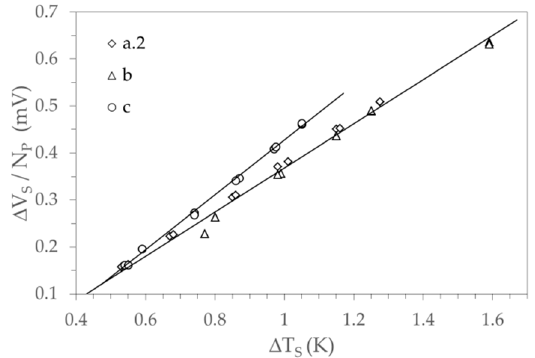
Figure 5. Seebeck voltage of a single pair (total Seebeck voltage divided by the number of pairs N P ) versus the estimated temperature di ff erence ∆ T S of the Seebeck junction.